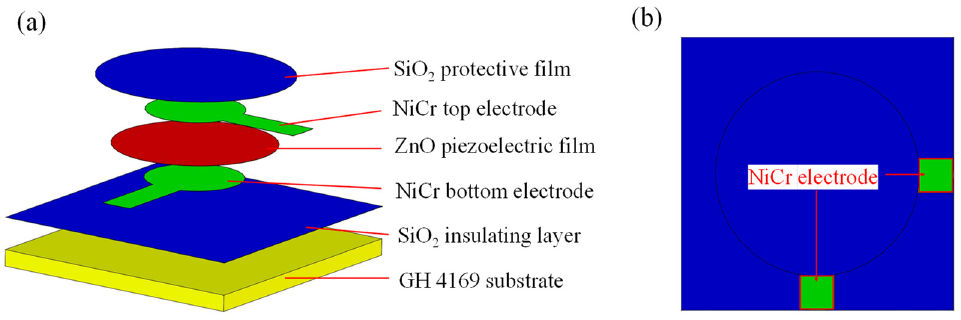
Figure 2. ( a ) Structural diagram of the piezoelectric film sensor; ( b ) structure of the leakage elec-